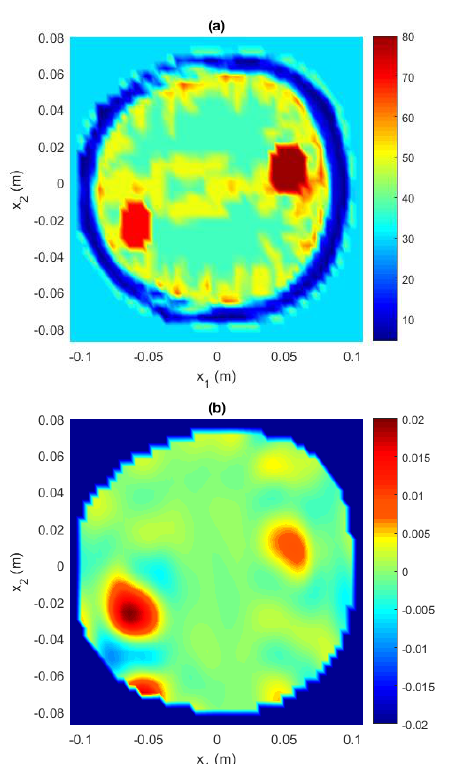
Figure 4: (a) Real parts of relative dielectric permittivity of 2-D head model with blood regions, (b) Detection of blood regions (Real parts of 𝛿𝑣 ).